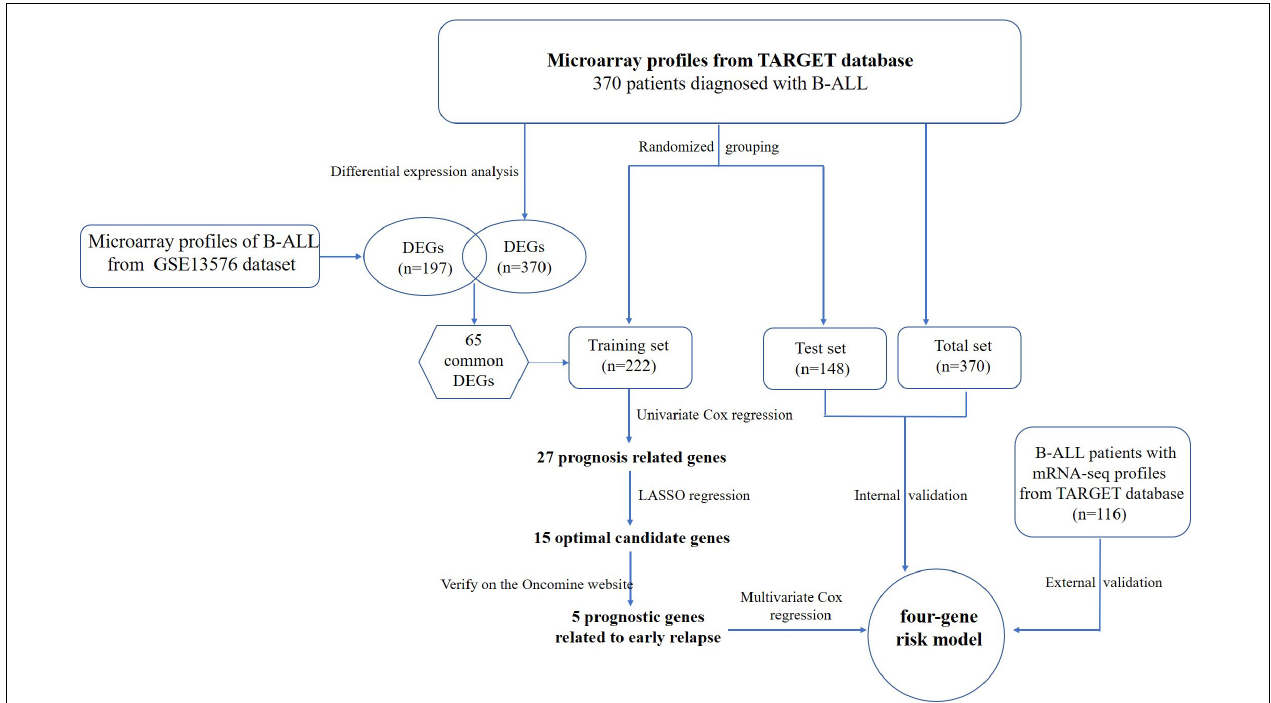
FIGURE 1 | Flowchart of risk model